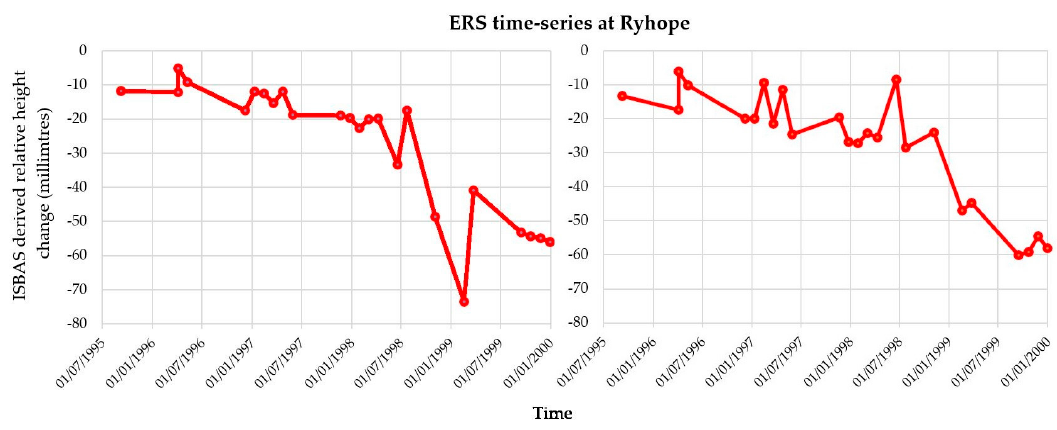
Figure 11. Selected ERS ISBAS time-series in the Ryhope subsidence depression, marked on Figure 8.